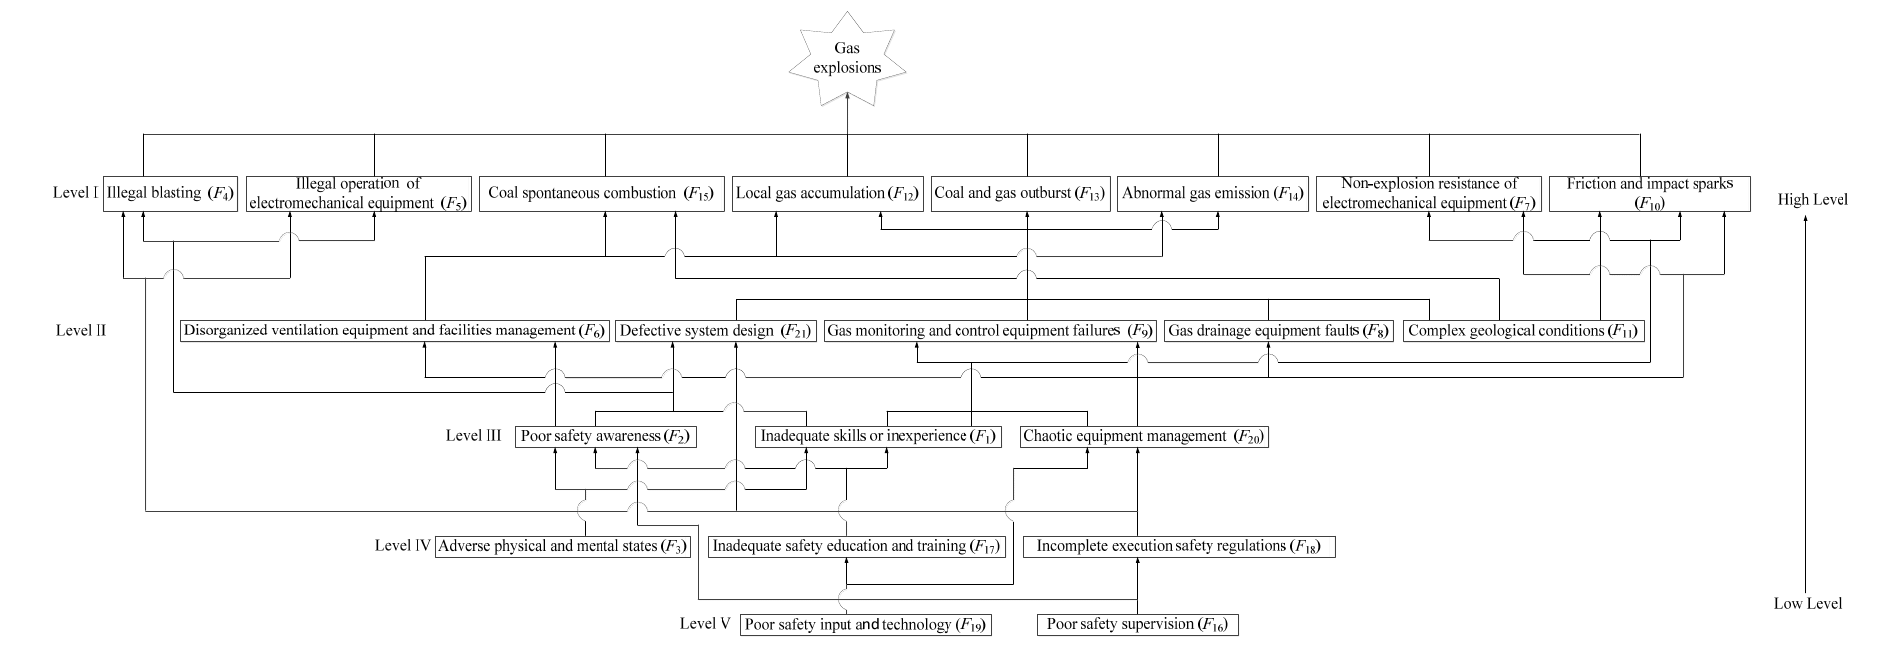
Figure 3. The hierarchical structure model of the representative risk factors of gas explosions.